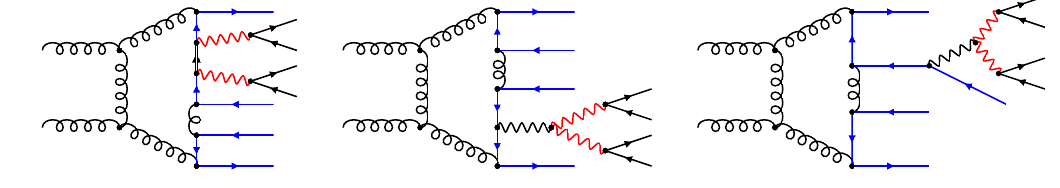
Figure 3 . Examples of octagon-, heptagon- and hexagon-type of one-loop diagrams contributing to the pp → e + ν e µ − ¯ ν µ b ¯ b b ¯ b + X process. The double line indicates the top (anti-top) quark, the blue line corresponds to bottom (anti-bottom) quarks whereas the W gauge boson is depicted in